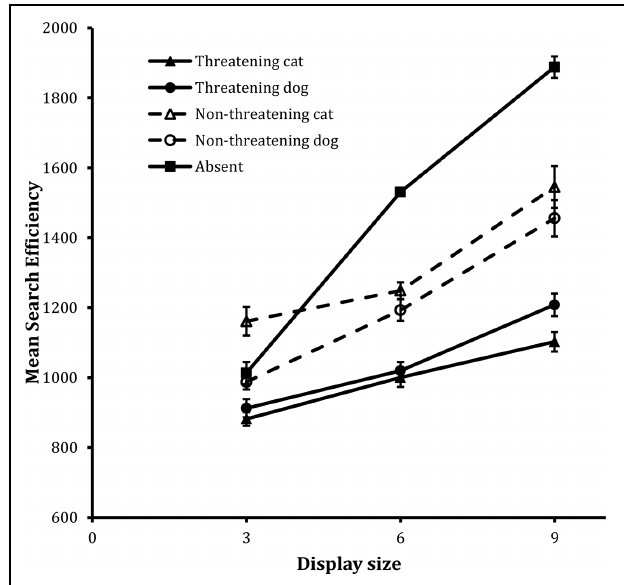
FIGURE 1 | Mean search efficiency scores as a function of both condition and display set size in the detection task in Experiment 1. Error bars reflect within-participant SE after variation between participants was removed (after Bakeman and McArthur,